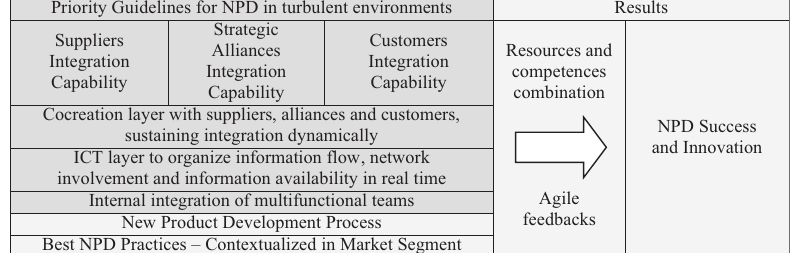
Figure 8. Cross-cutting best practices for NPD